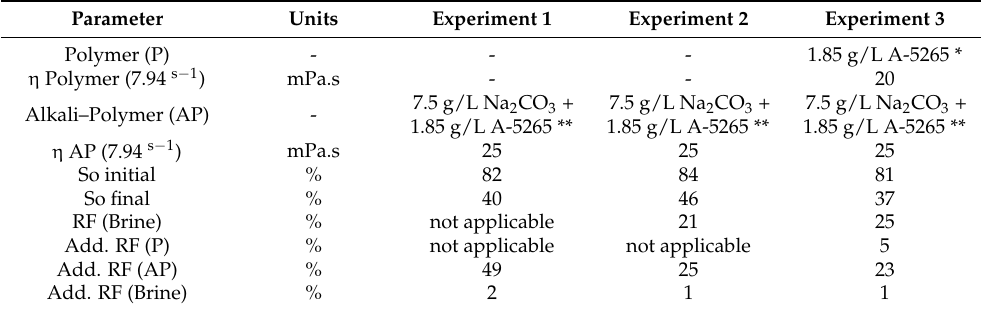
Table 8. Summary of results obtained for micromodel flood experiments performed in this work. Pore pressure was 1 bar and injection rate was 1 ft/day in all cases. Temperature, 49 ◦ C. High-permeability zone refers to 6 darcys and low-permeability zone to 1.5